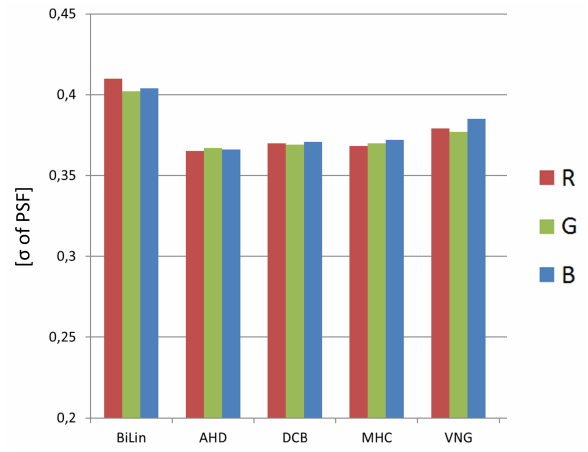
Figure 4. Comparison of different de-mosaicing methods for (R)ed, (G)reen and (B)lue channel calculated for each pixel by comparing values in the 5x5 neigh- bourhood. The gradient is calculated by summing up the absolute difference of like-coloured pixels. A threshold is used to deter- mine if the pixel lies on a smooth area and averaging can be used to approximate the missing values, or if the pixel lies on a steep gradient, where it is better to use one of two neighbouring